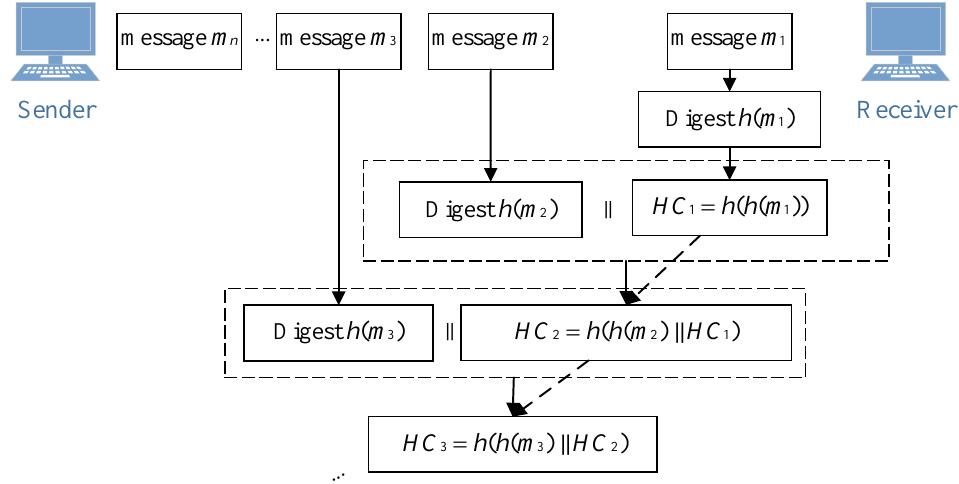
Figure 3. Construction method of the message hash chain.